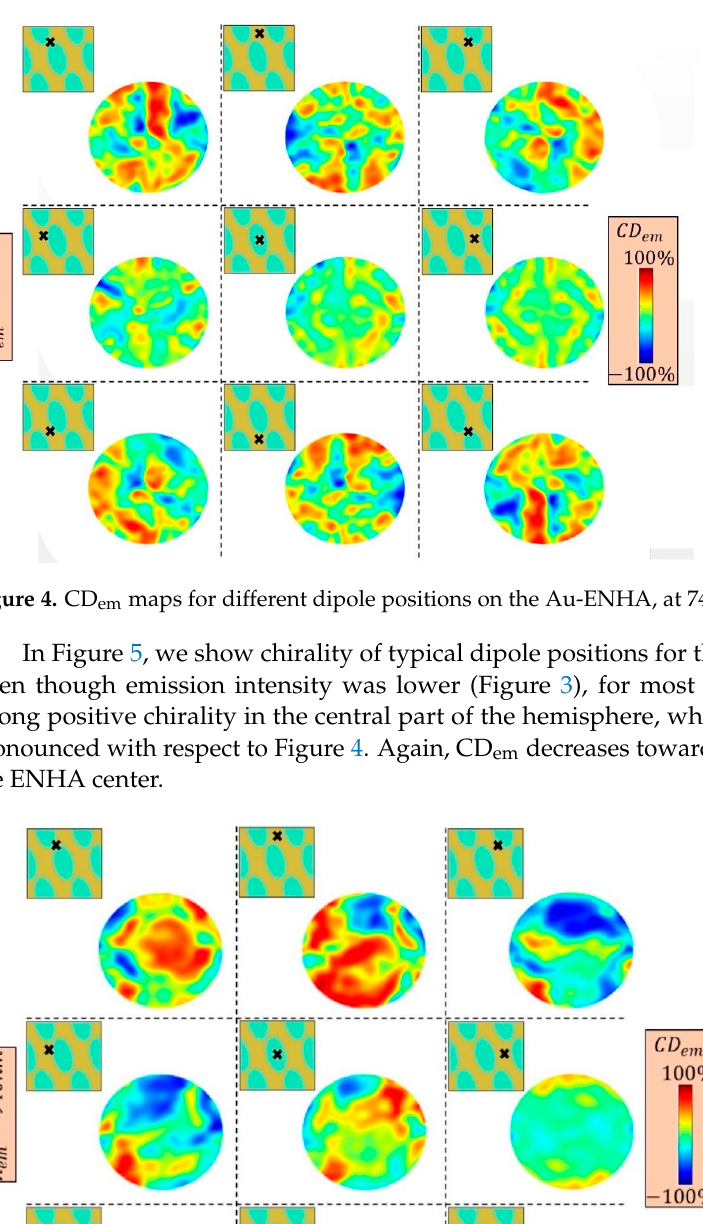
Figure 3. Simulation results for a randomly oriented dipole positioned at Δ x = 0, Δ y = a/2, and Δ z = 120 nm, emitting at 740 nm (top), and 940 nm (bottom); we performed three simulation runs for